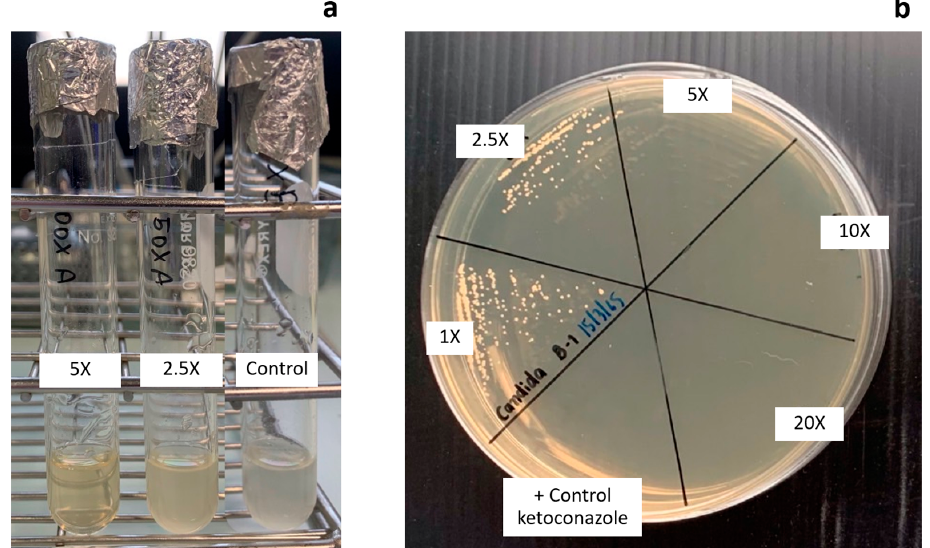
Figure 5. Antifungal test result of the ethosome loaded with different concentration of Z. zerumbet (L.) rhizome extract from ( a ) broth dilution technique test and ( b ) streaking onto the surface of Sabouraud dextrose agar.